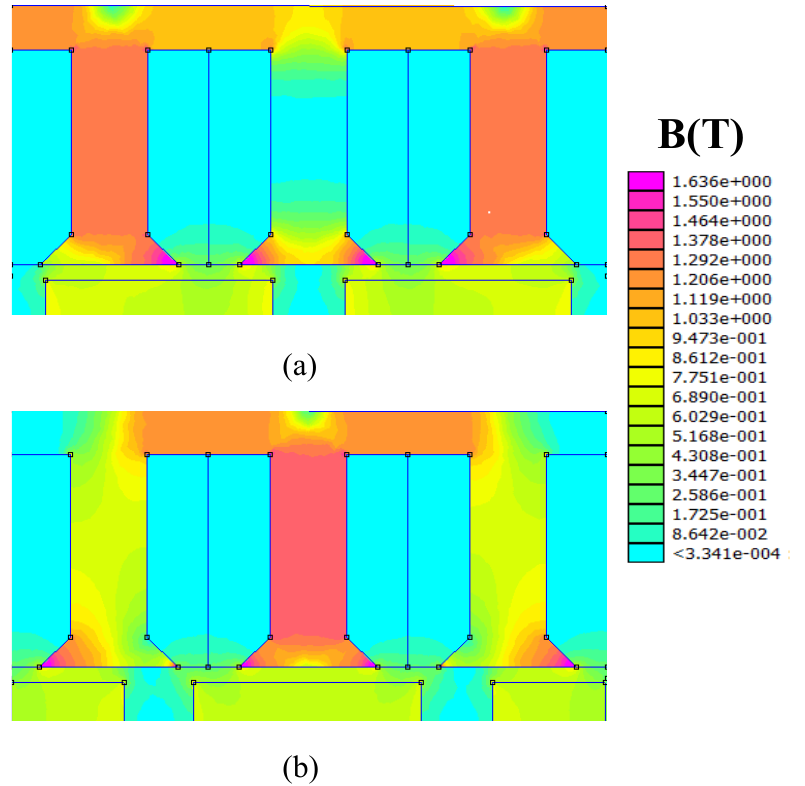
Figure 20. Flux density distribution. ( a ) Stator’s tooth center is between two adjacent magnets. ( b ) Magnet center is aligned with the stator’s